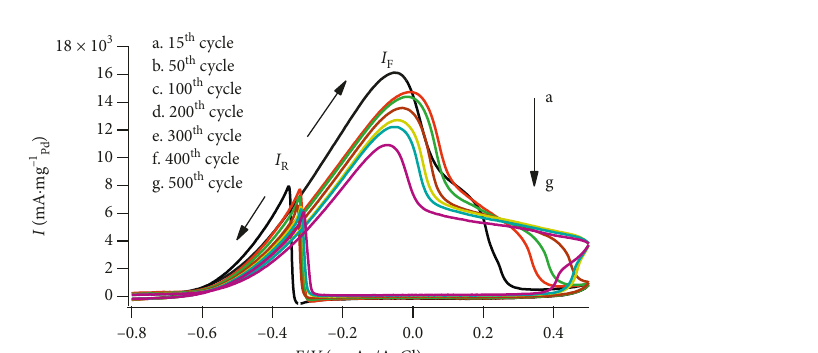
Figure 7: CV curves of catalytic PASGN.N after 500 scanning cycles in a (NaOH 0.5 M + C 50 mV · s − 1 .